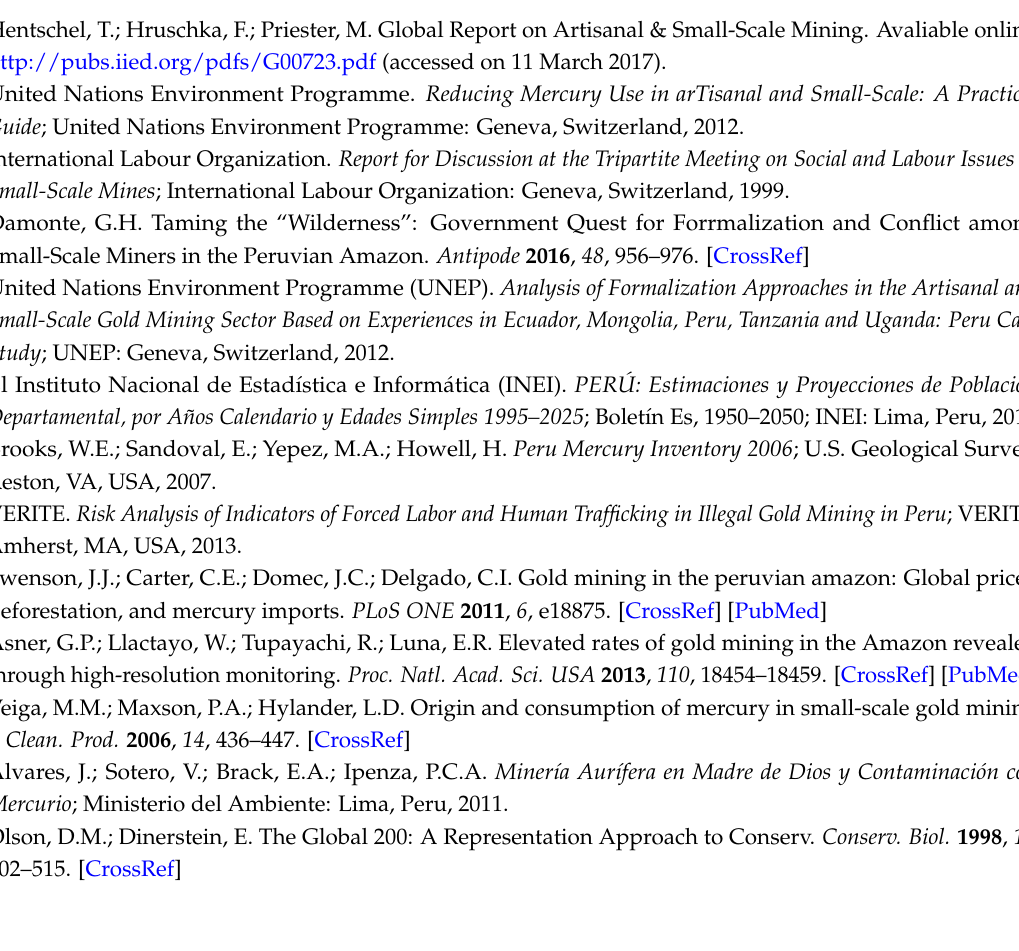
Figure S1: Comparison of mercury in paco fish tissue by study site: mean wet weight mercury concentration (mg/kg), mean dry weight mercury concentration